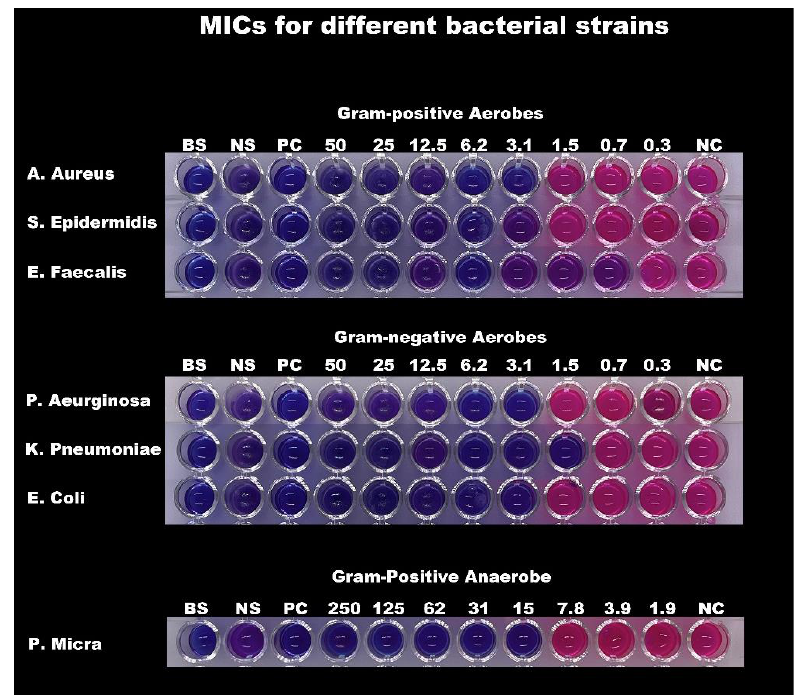
Figure 3. MICs of C-CaOH 2 NPs on the tested aerobic and anaerobic bacteria. BS: Broth sterility; NS: C-CaOH 2 NPs sterility; PC: positive control Ciprofloxacin; wells from 50 to 0.3 and 250 to 1.9 are the two-fold serial dilutions of C-CaOH 2 NPs; and NC: negative control.